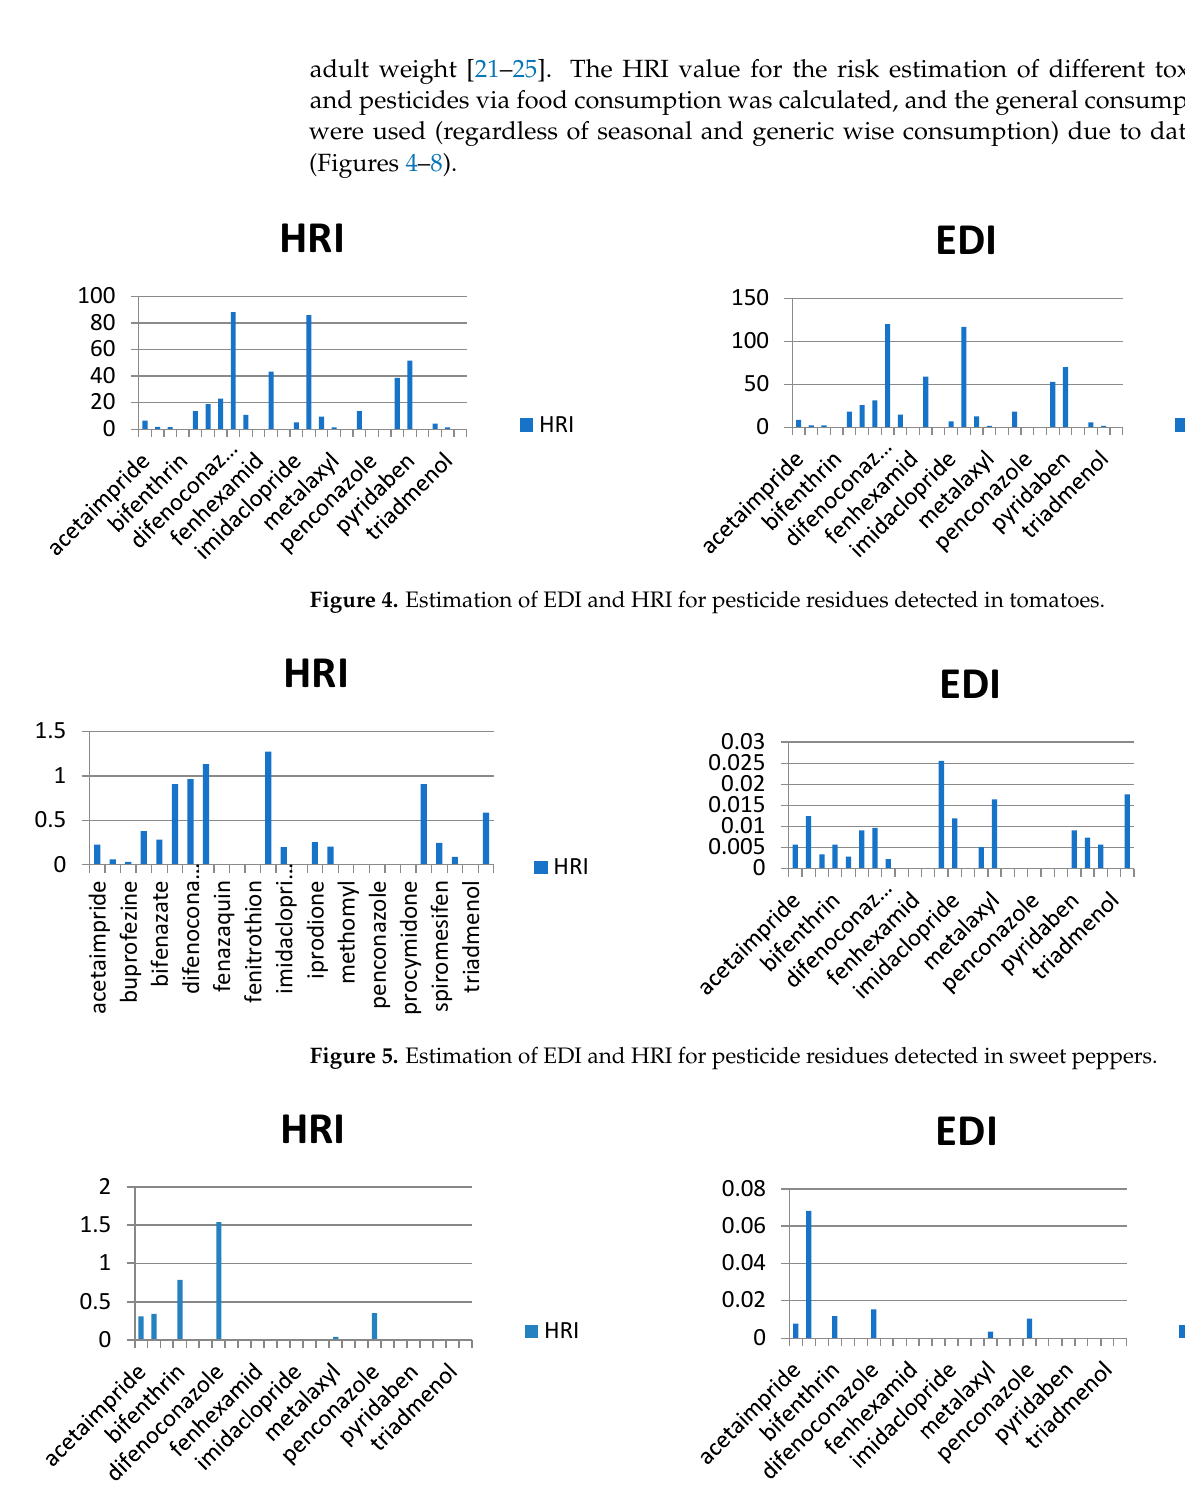
Figure 6. Estimation of EDI and HRI for pesticide residues detected in squash.